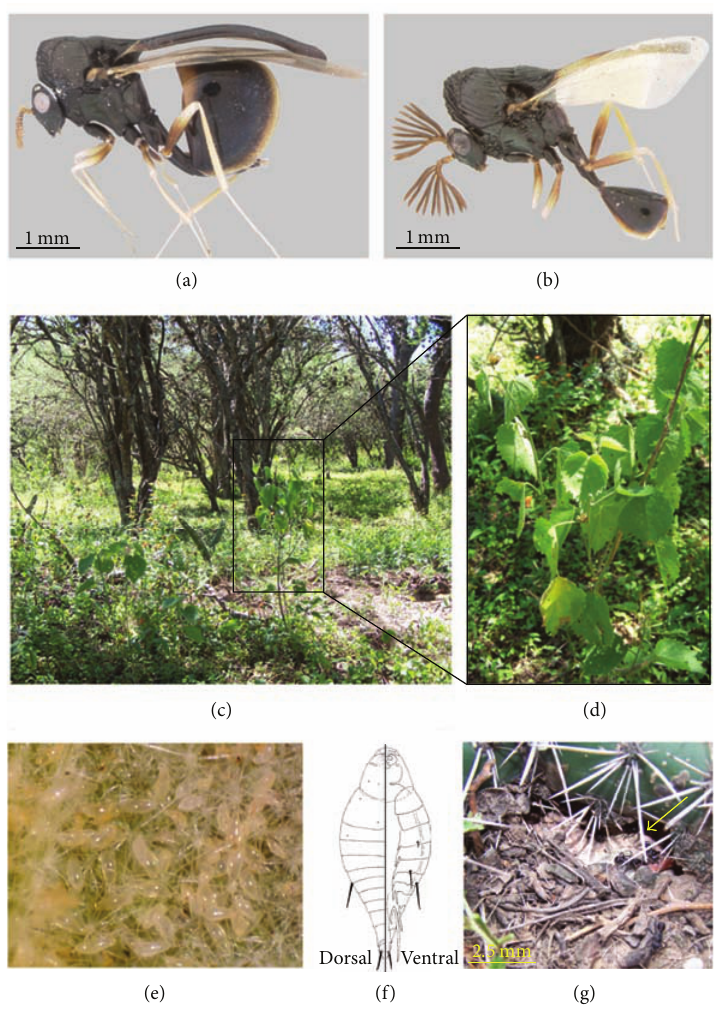
Figure 1: Dicoelothorax platycerus : (a) habitus (female); (b) habitus (male). Biology and immature stage of D. platycerus : (c) habitat; (d) Pseudabutilon virgatum ; (e) underside of leaf of P. virgatum with eggs; (f) planidium (dorsal and ventral); (g) nest entrance of Ectatomma brunneum (opening indicated). Figures extracted from